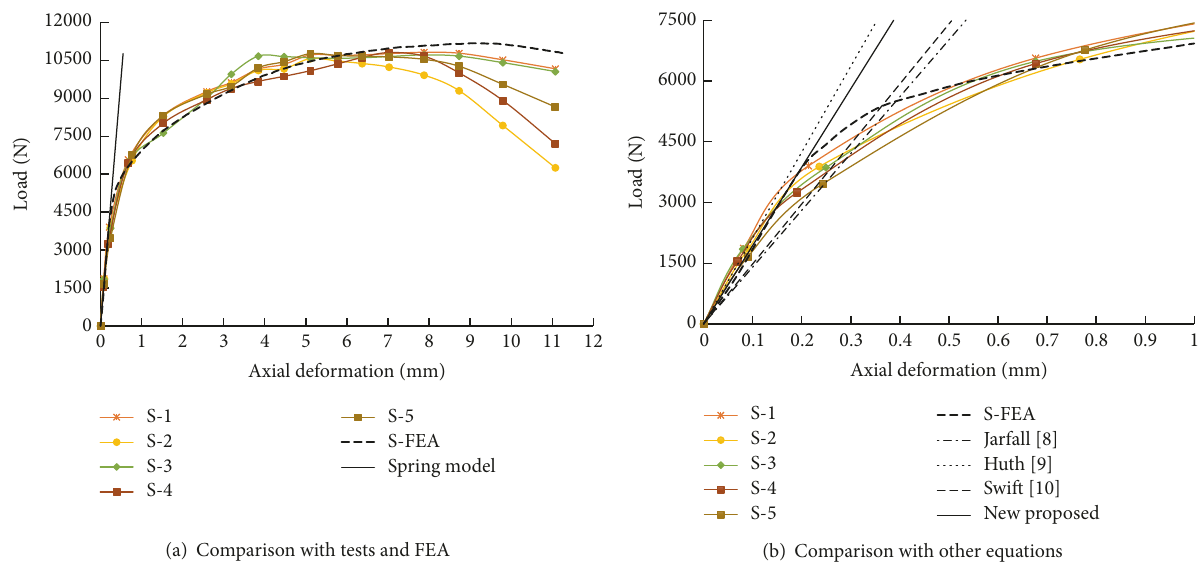
Figure 18: Comparison of the load-deformation curve of the proposed spring